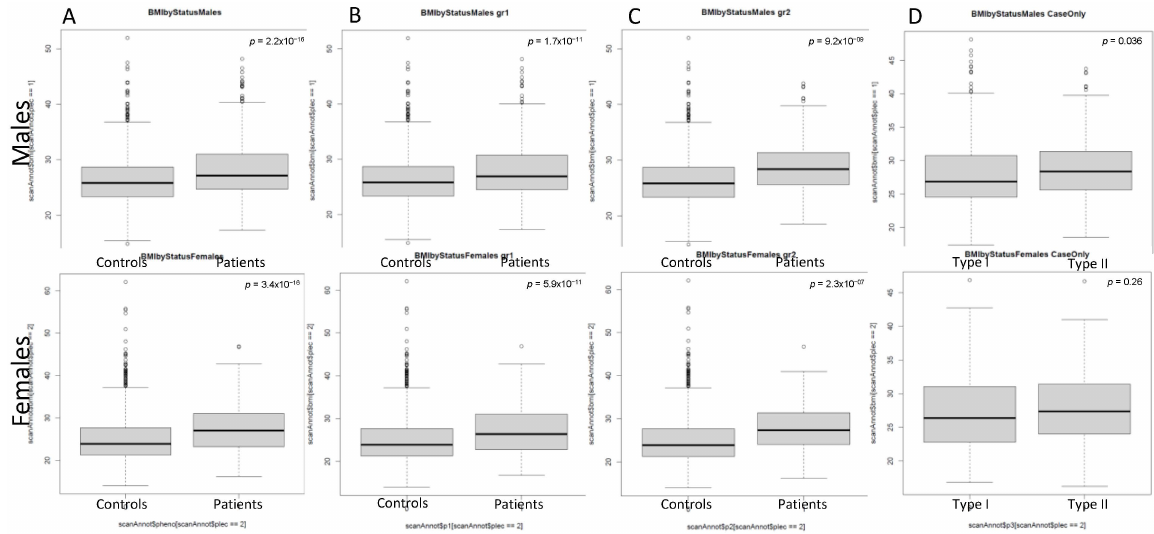
Figure 1. Boxplot of BMI (body mass index, kg/m 2 ) among the study group (by gender): Panel ( A – C ) depicts the summary statistics of BMI in control group versus all psoriatic patients ( A ), type I psoriatic patients ( B ), and type II psoriatic patients ( C ), respectively. Panel ( D ) compares BMI of type I psoriatic patients vs. type II psoriatic patients. The central line in each box indicates the sample median, the boxes represent the 25th and 75th percentile; whiskers represent the confidence interval for the sample quantiles. Circles represent outliers. The p values for the Wilcoxon test are presented for every pair of